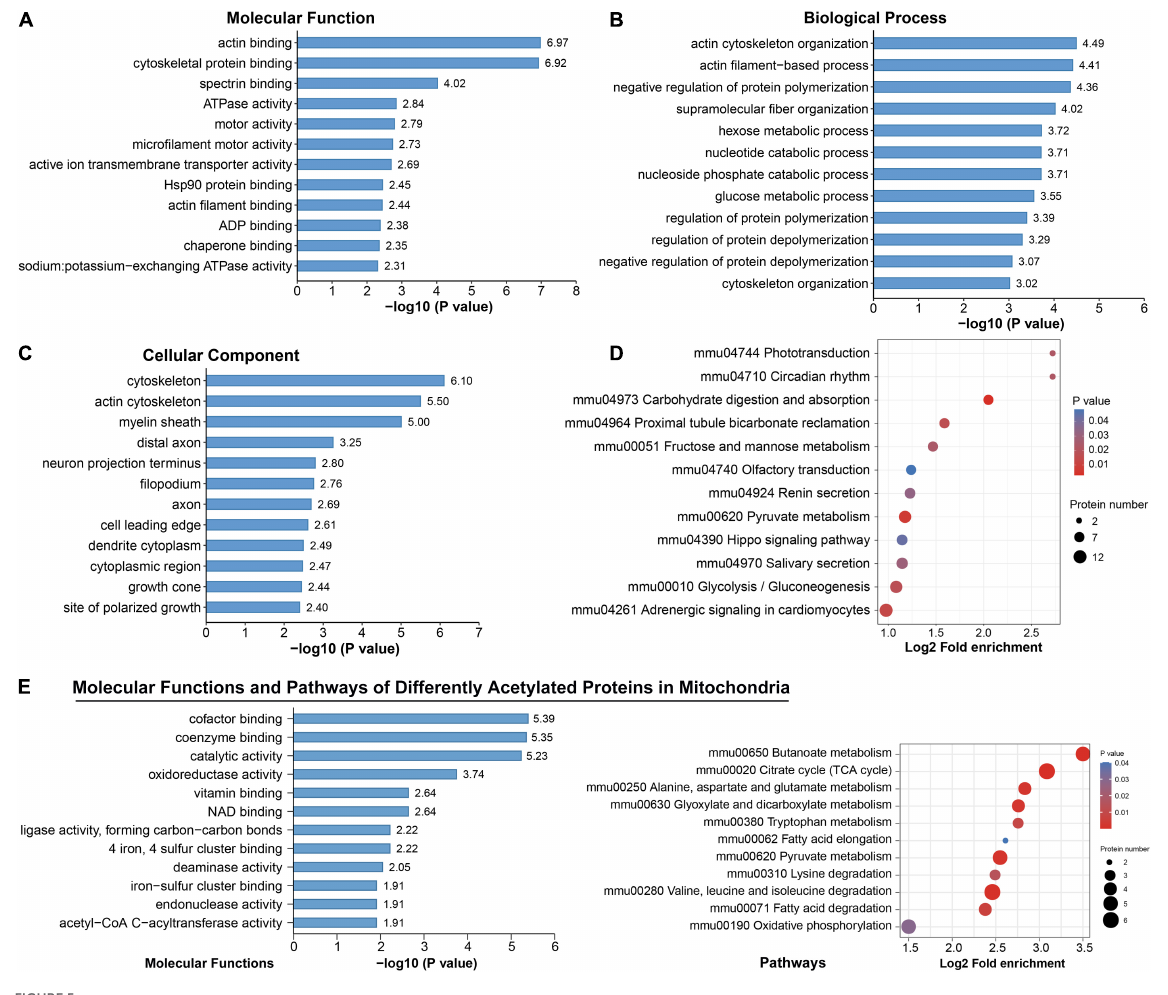
FIGURE5 Functional enrichment analysis for differentially acetylated proteins. (A–D) Representative Gene Ontology (GO) enrichment analysis (molecular function, cellular component, biological process) (A–C) and enrichment analysis of Kyoto Encyclopedia of Genes and Genomes (KEGG) pathways (D) of all differentially acetylated proteins. (E) Molecular function and KEGG pathways of 47 proteins that were differentially acetylated in